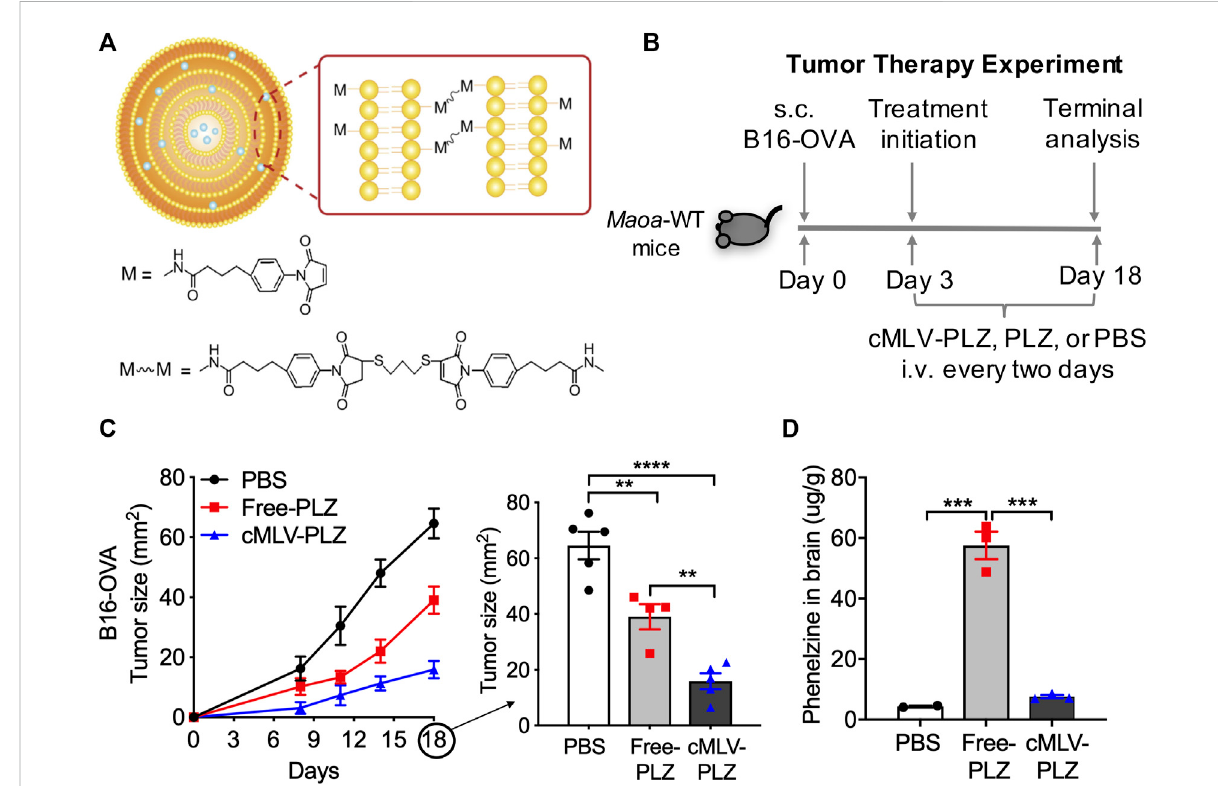
FIGURE 1 Nanoformulation increases phenelzine-mediated antitumor activity. (A) Schematic of cMLV crosslinking design (B) Study design for evaluating thecancer therapy potential ofcMLV-formulated phenelzine (cMLV-PLZ, 30 mg/kg)in aB16-OVAmousemelanoma model. Free phenelzine (Free- PLZ, 30 mg/kg) was included as a control. (C) Tumor growth ( n = 5) over an 18-days time course study. At day 18, a signi fi cant reduction in tumor growthwasobservedincMLV-PLZtreatedmicecomparedtofreephenelzineofcomparabledosage (D) Phenelzine(PLZ)measurementsinthe brain ( n = 3). At day 18 after tumor challenge, 2 h after fi nal drug injections, mouse experiments were terminated and brain tissues were collected. Measurements were obtained through quantitative reverse phase High Performance Liquid Chromatography on brain tissue samples. Data